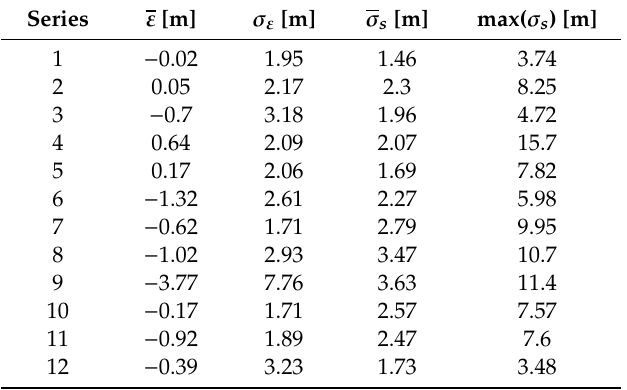
Table 1. Evaluation of position estimation accuracy.